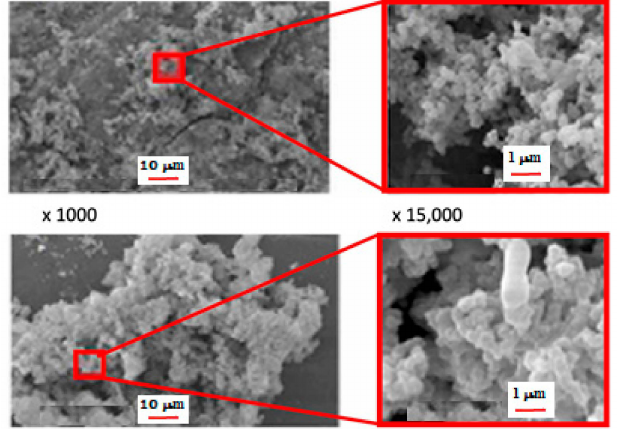
Figure 20. SEM micrographs at increasing magnifications of the same area reporting the microstruc- ture of geopolymer material exposed to SBF solution for 28 days